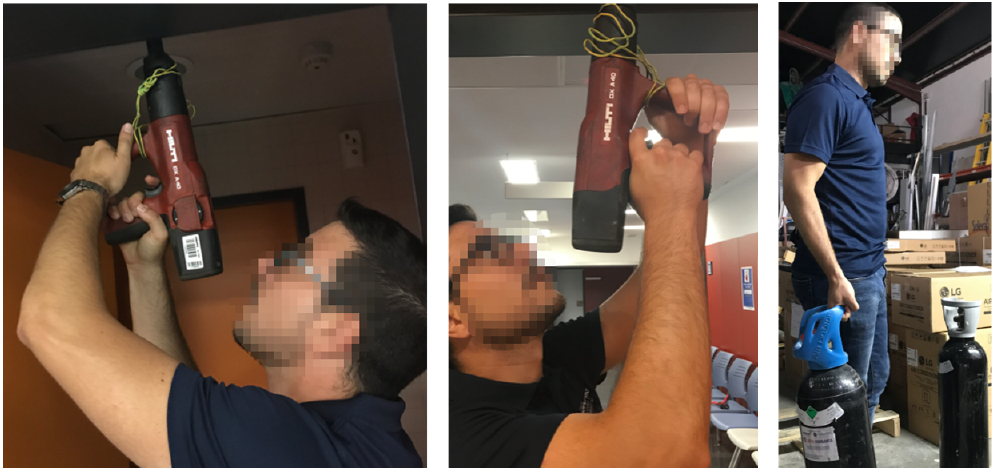
Figure 1. Examples of industrial maintenance tasks: work tasks with the hands overhead in drilling holes into the ceiling and lifting and carrying loads. All the participants that appear in the figure have provided written and informed consent for its